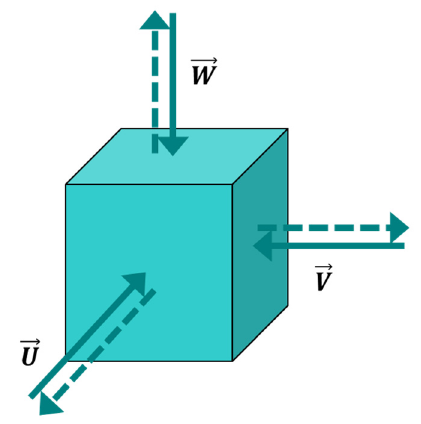
Figure 3. Three-dimensional motion of air through a city.